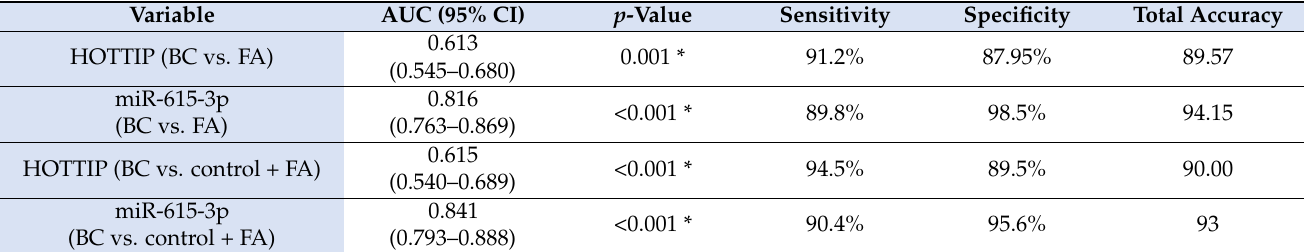
Figure 3. Spearman correlation between the HOTTIP and miR-615-3p serum expression levels in patients with BC. ** Significant at p < 0.001. Table 5. ROC curve of the serum HOTTIP and miR-615-3p.